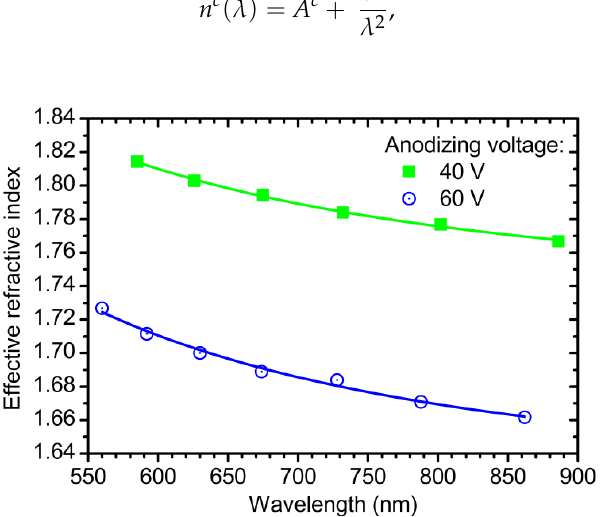
Figure 1. Wavelength dispersions of the effective refractive index of the anodic titanium oxide films obtained at 40 V (green squares) and 60 V (blue circles) without additional etching in electrolyte solution. Solid lines represent the fitting of experimental points by Cauchy dispersion.